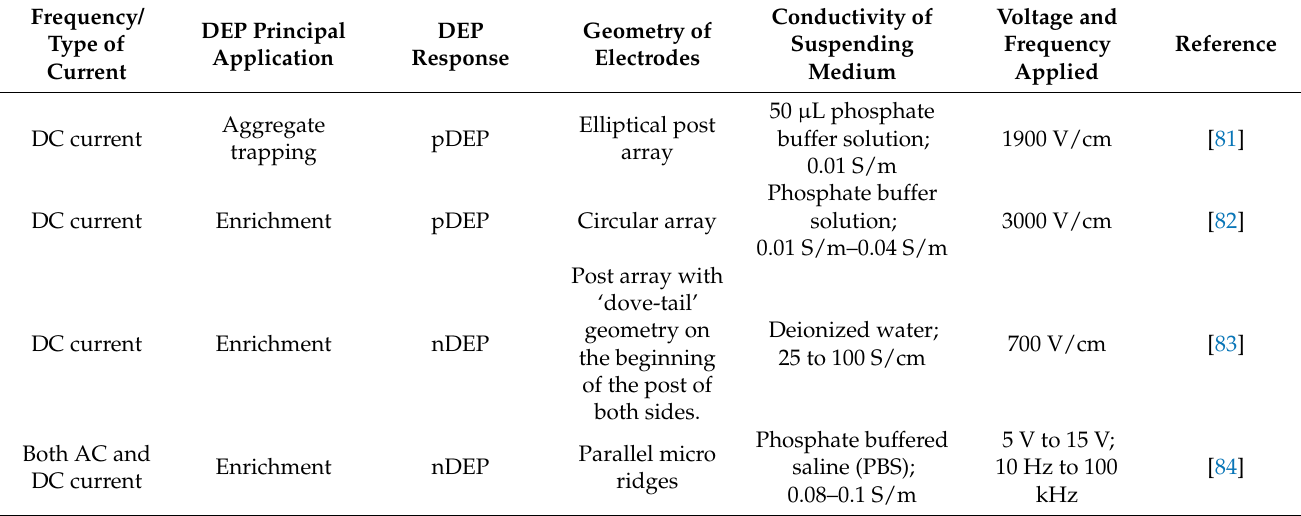
Table 4. Insulator-based DEP type of electrode configuration studied for protein BSA.